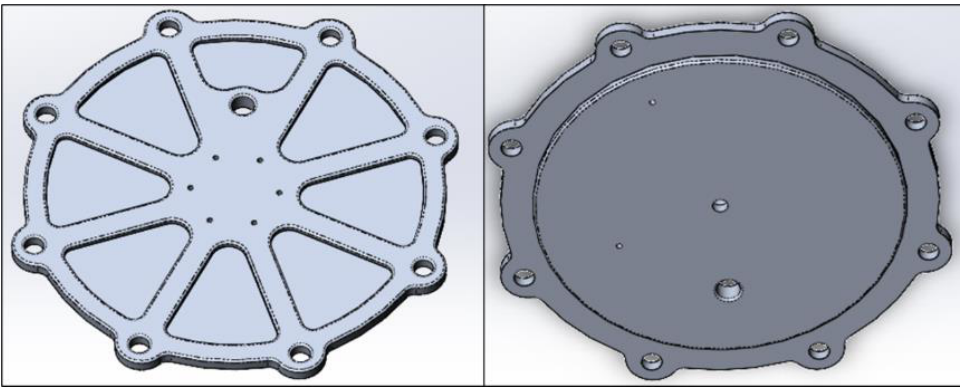
Figure 5. WCH lid final design: top surface ( left ), bottom surface ( right ).